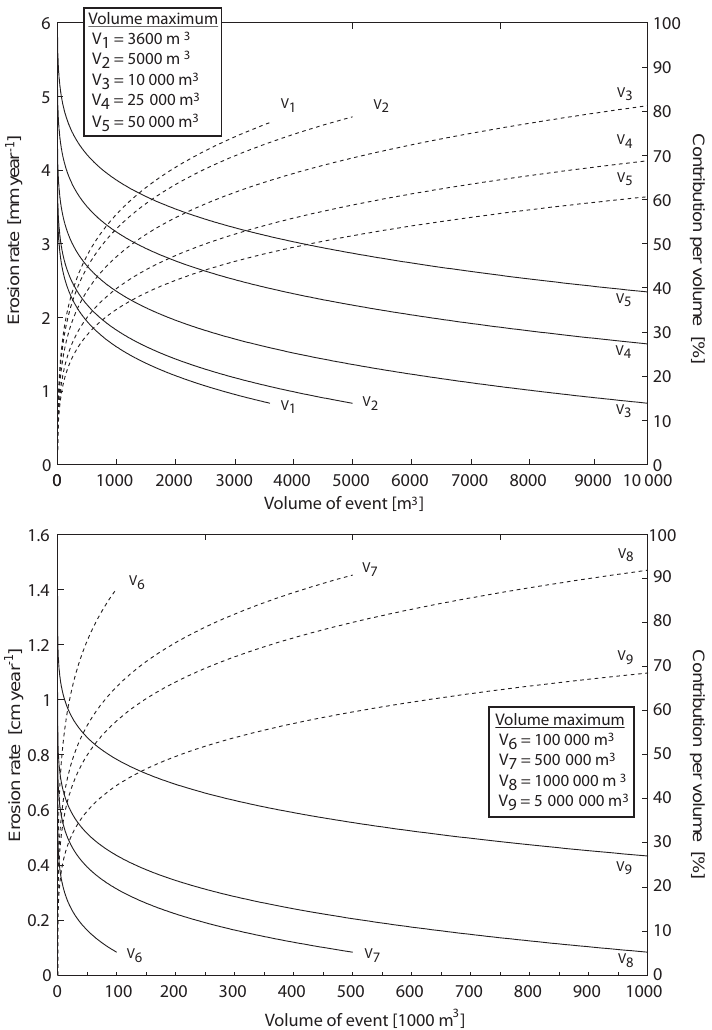
Figure 16. Continuous lines: erosion rate as function of size of events for a certain volume of production (potential maximum volume V 1 ... 9 ), considering that rockfall volume distribution observed at Manival follows power law behaviour (Table 6). Dashed lines: contribution of each class of volumes to the erosion rate showing the significant effect of large slope failures. For a maximum eroded volume of 3600m 3 yr − 1 (V 1 ), the 1000m 3 rockfall event contributes 60%, while events less than 100 m 3 induce less than 20% of erosion, although they are of